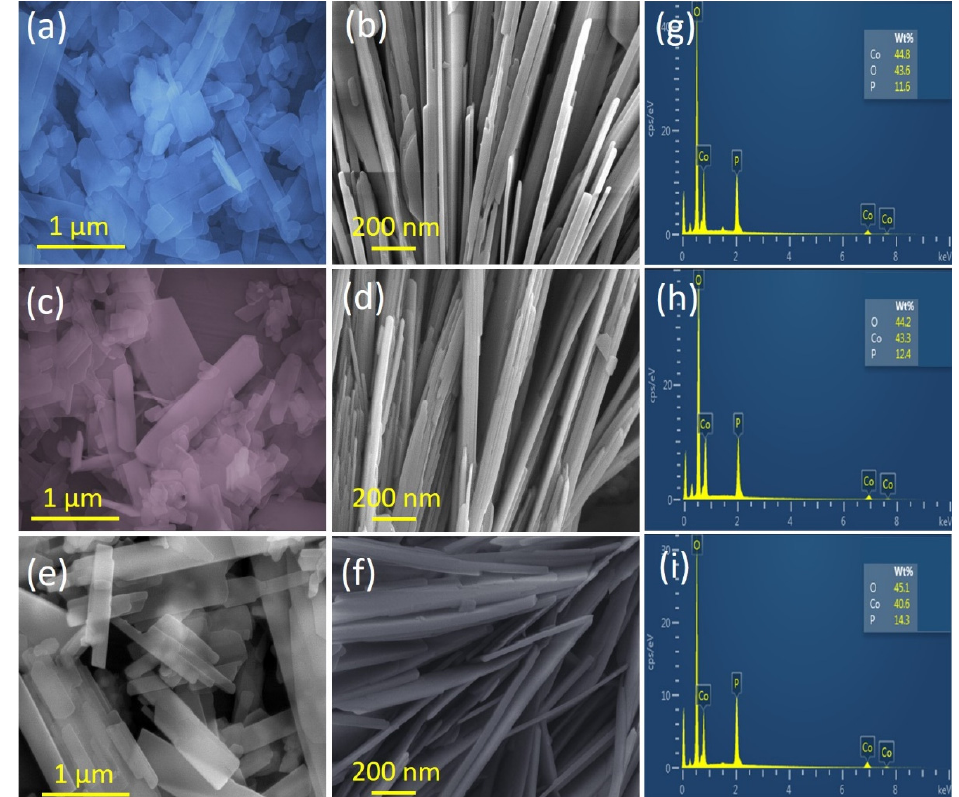
Figure 2. ( a – f ) SEM images of the Co 2 P 2 O 7 materials synthesized at various deposition temperatures of 120, 150, and 180 °C, respectively, ( g – i ) EDS of the Co 2 P 2 O 7 materials synthesized at various deposition temperatures of 120, 150, and 180 °C, respectively.